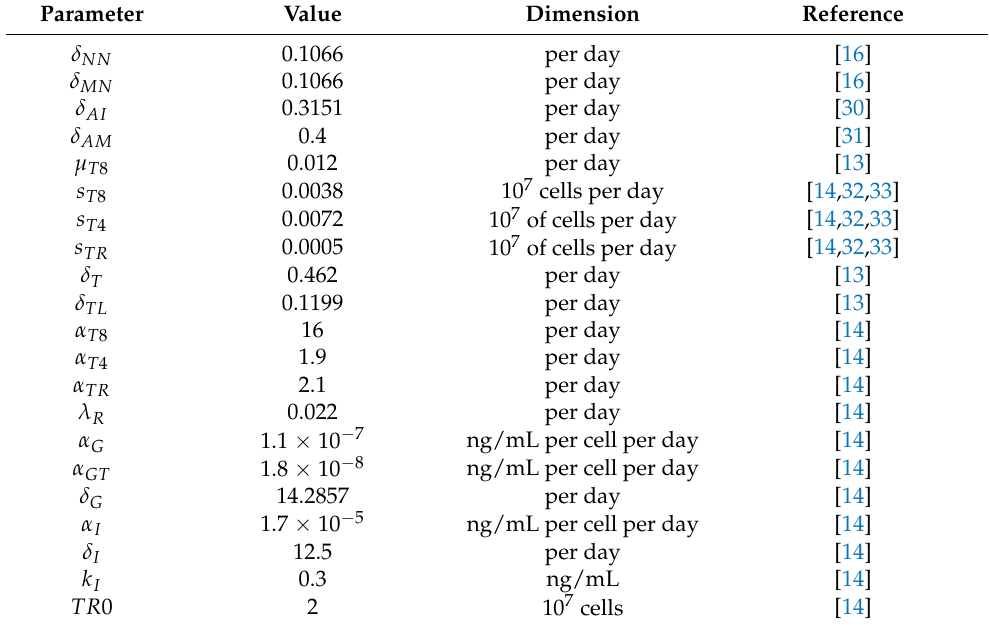
Table 2. Parameter values obtained from the literature.